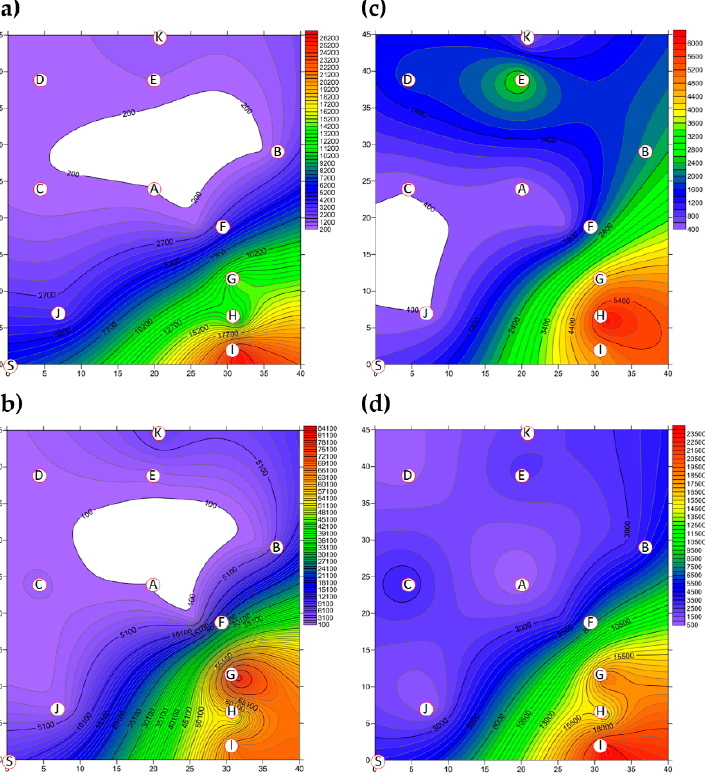
Figure 5. The bacterial bioaerosols (BBs) (CFU m − 3 ) present as ( a ) LPBs and ( b ) SPBs in Market A before operations commenced and the concentrations of ( c ) LPBs and ( d ) SPBs present after operations had finished. Red circular dots with English titles show sampling locations. Bioaerosols in the white area had values below the scale. Table 4. Average concentrations and percentages of large particle bioaerosols (LPB) and small particle bioaerosols (SPB) in the two indoor